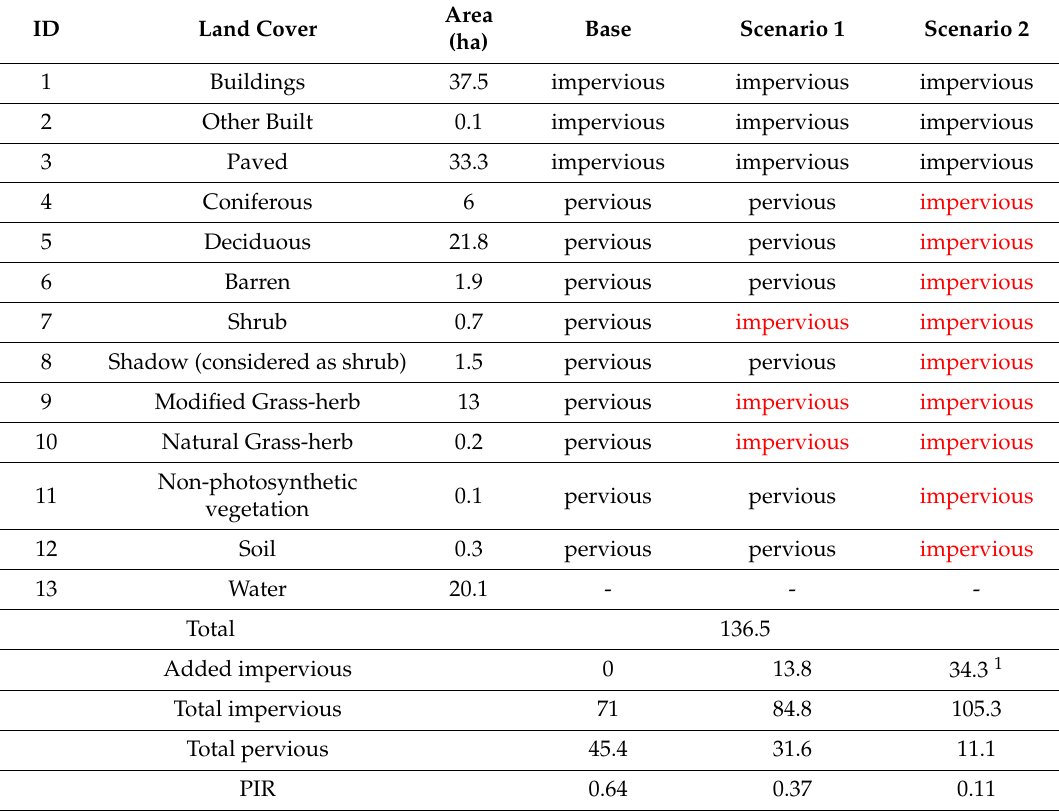
Table 6. Land cover data of Vancouver at the year 2014 [59] and its projected changes due to the urban growth for Scenario